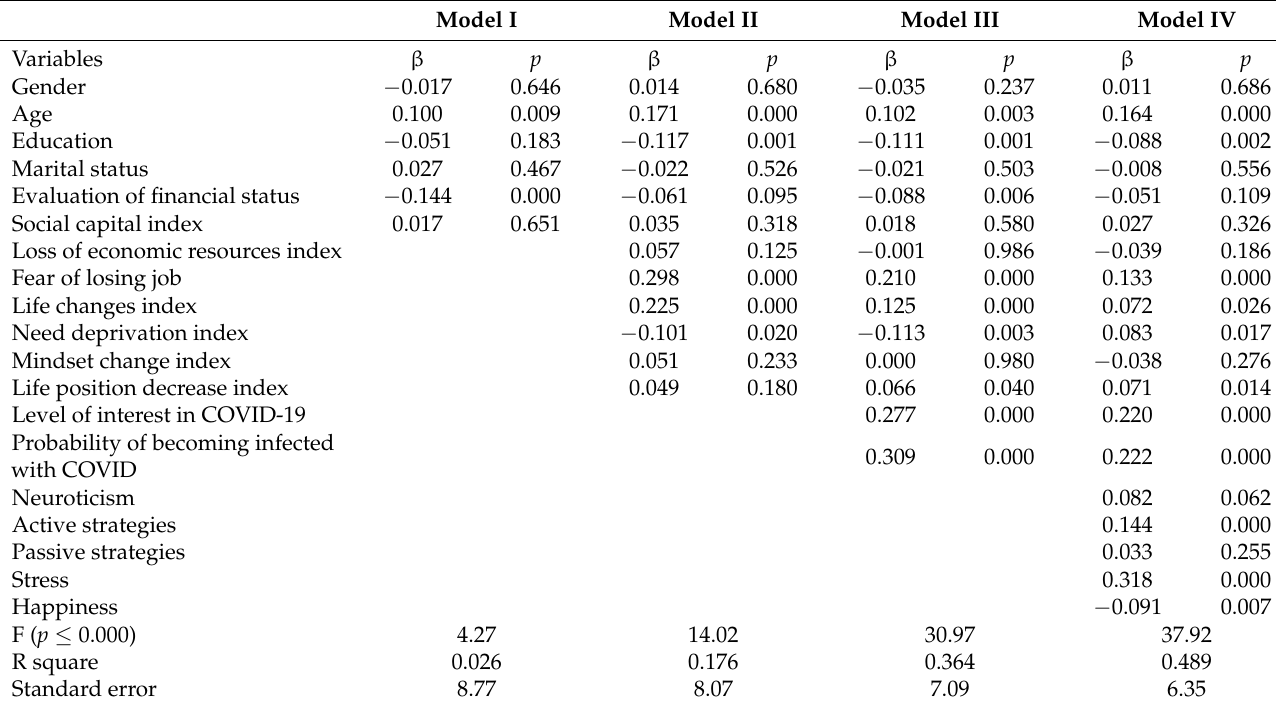
Table 4. Results of hierarchical regression